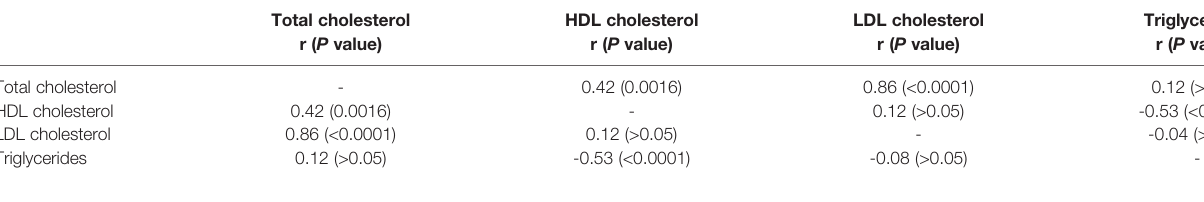
TABLE 4 | Spearman rank correlation coef fi cients between total cholesterol, HDL-cholesterol, LDL-cholesterol, and triglycerides in children with type 1 diabetes.